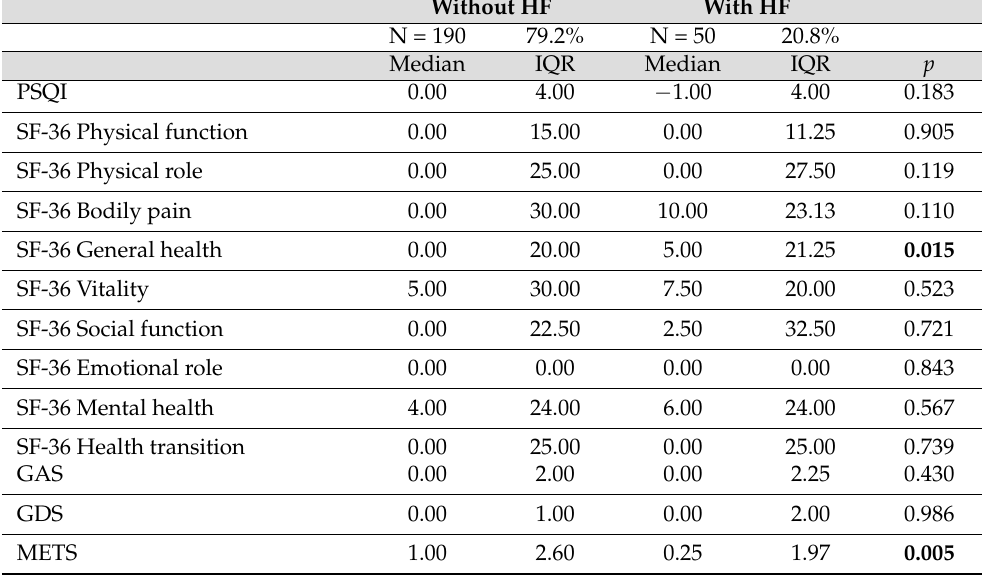
Table 7. Comparison of differences between baseline and final values based on heart